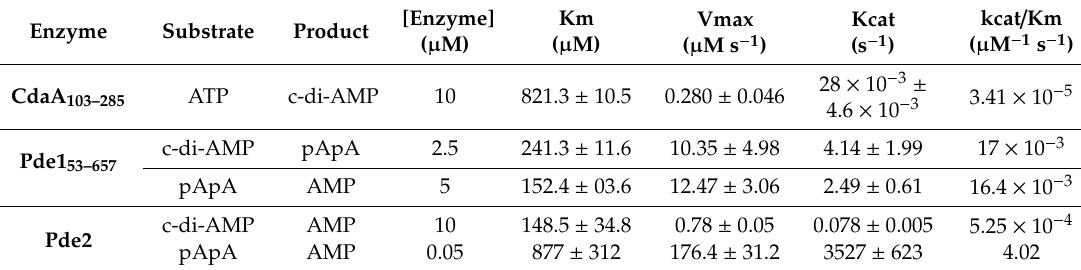
Figure 2. Steady-state kinetics of product formation by CdaA 103–285 , Pde1 53–657 and Pde2. ( a ) C-di-AMP synthesis from ATP by CdaA 103–285 . ( b ) C-di-AMP hydrolysis to pApA by Pde1 53–657 . ( c ) pApA degradation to AMP by Pde1 53–657 . ( d ) C-di-AMP and ( e ) pApA hydrolysis to AMP by Pde2. Shown are average values and standard deviation of at least two individual experiments. Table 2. Enzyme kinetics parameters/results.